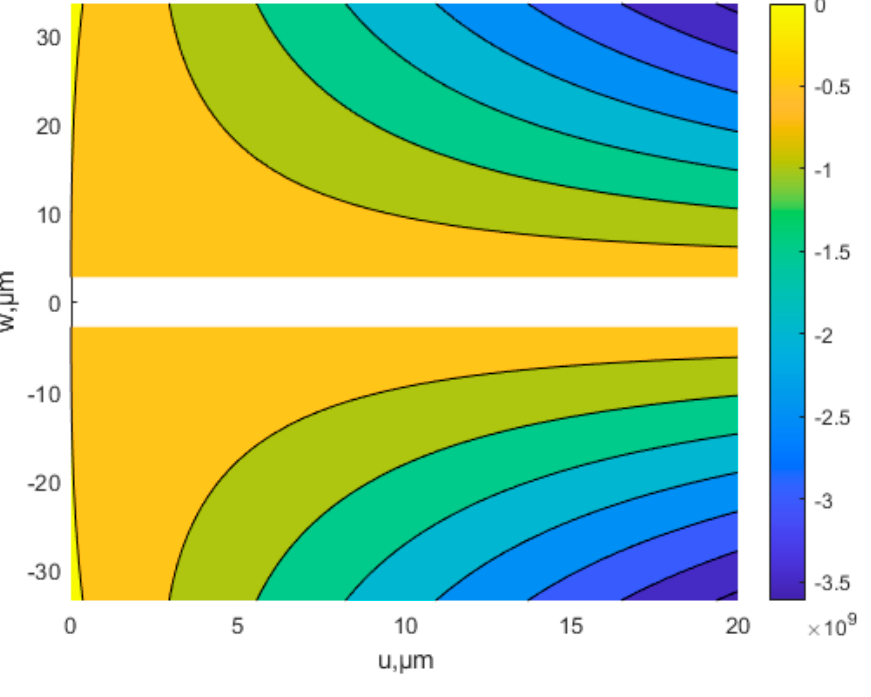
Figure 9. Contour line of membrane energy.